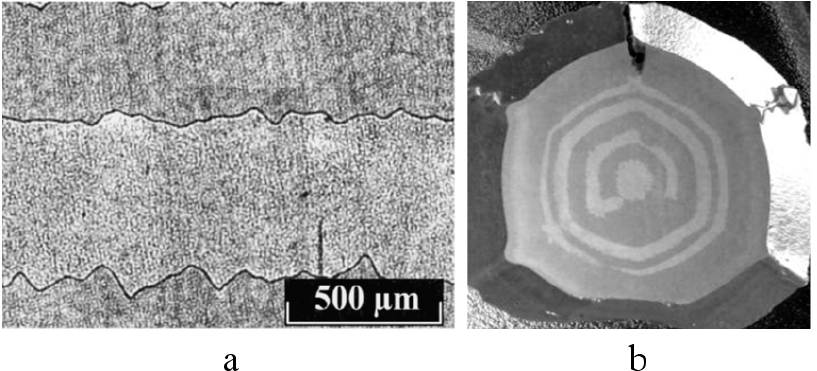
Figure A3. Growth bands in heavily doped LiNbO 3 :Mg crystals (direct doping): ( a )–X-cut; ( b )–Z- cut.